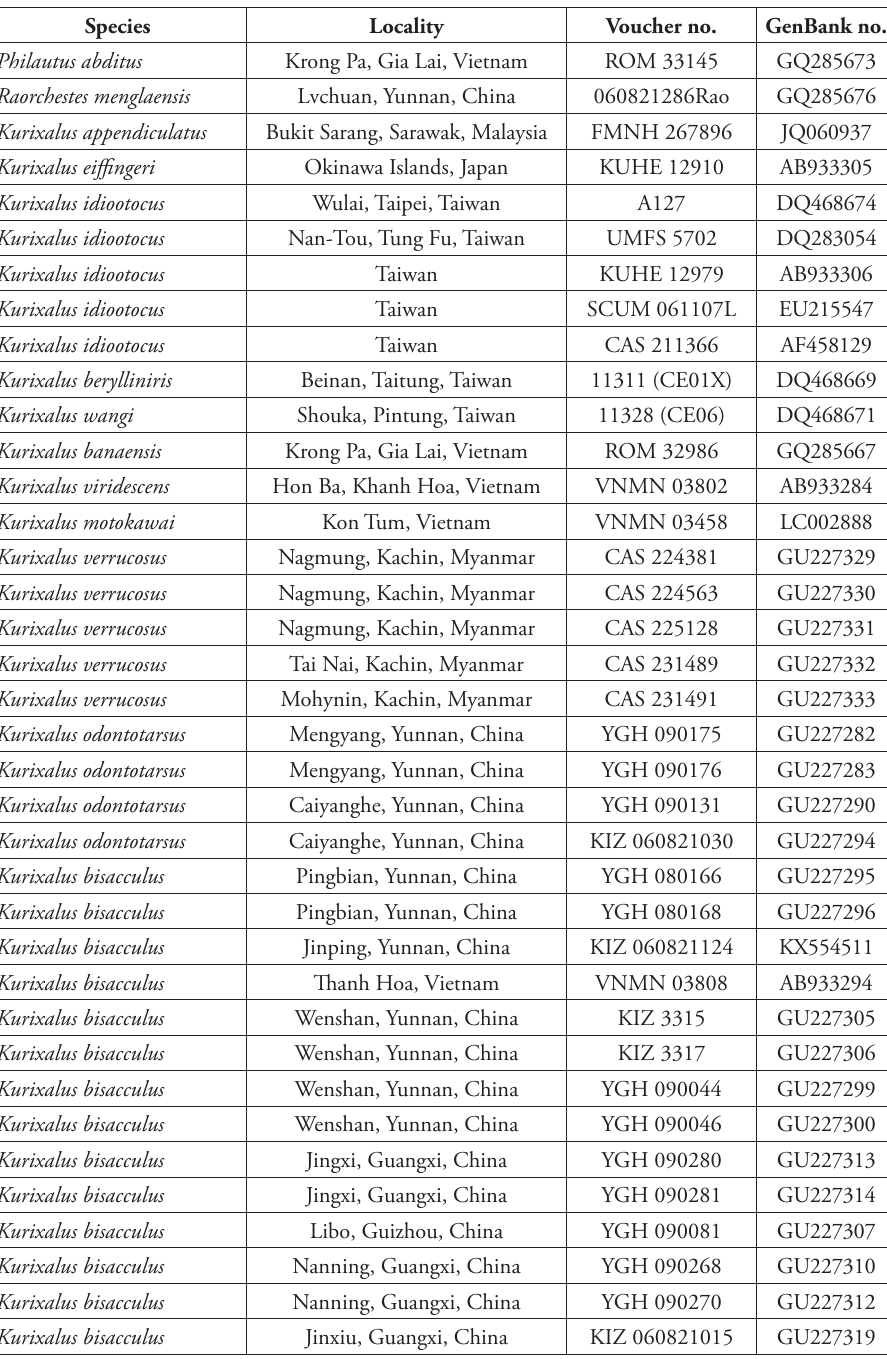
Table 1. Sequences used in this